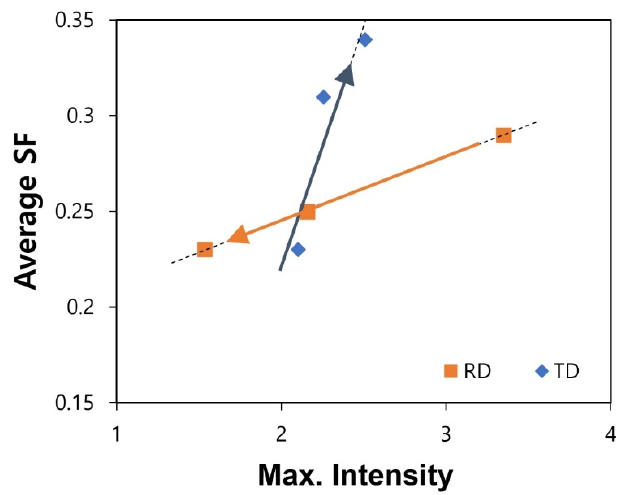
Figure 8. Relationship between the average SFs and the maximum intensities of basal poles along the RD and TD. Arrow direction indicates a decrease in the Al content.